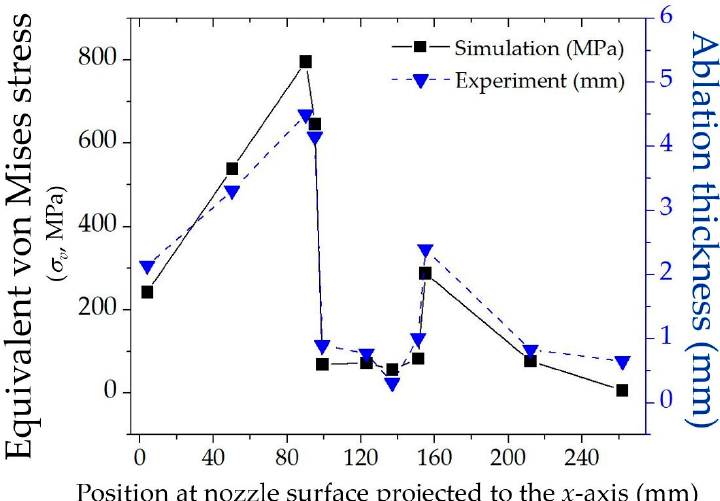
Figure 19. Comparison between the equivalent von-Mises stress from the CHTA simulation and the ablation’s thickness from the experiment.